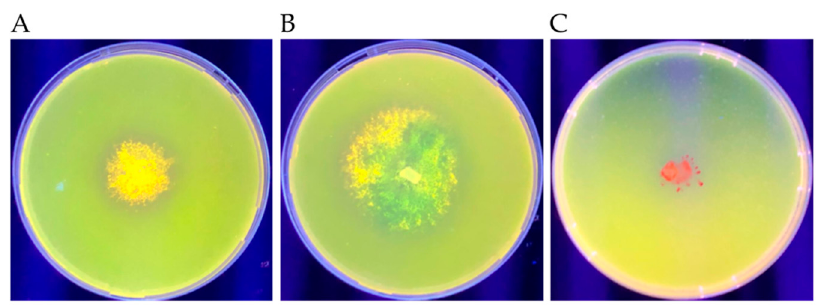
Figure 6. Lipase assay with Rhodamine 6G under UV light. ( A , B ) Yellow- to orange-colored fluorescence as a positive result. ( C ) Growth with no fluorescence as a negative result. Table 4. Lipase activity of selected isolates cultured on olive oil and Rhodamine 6G agar plates.